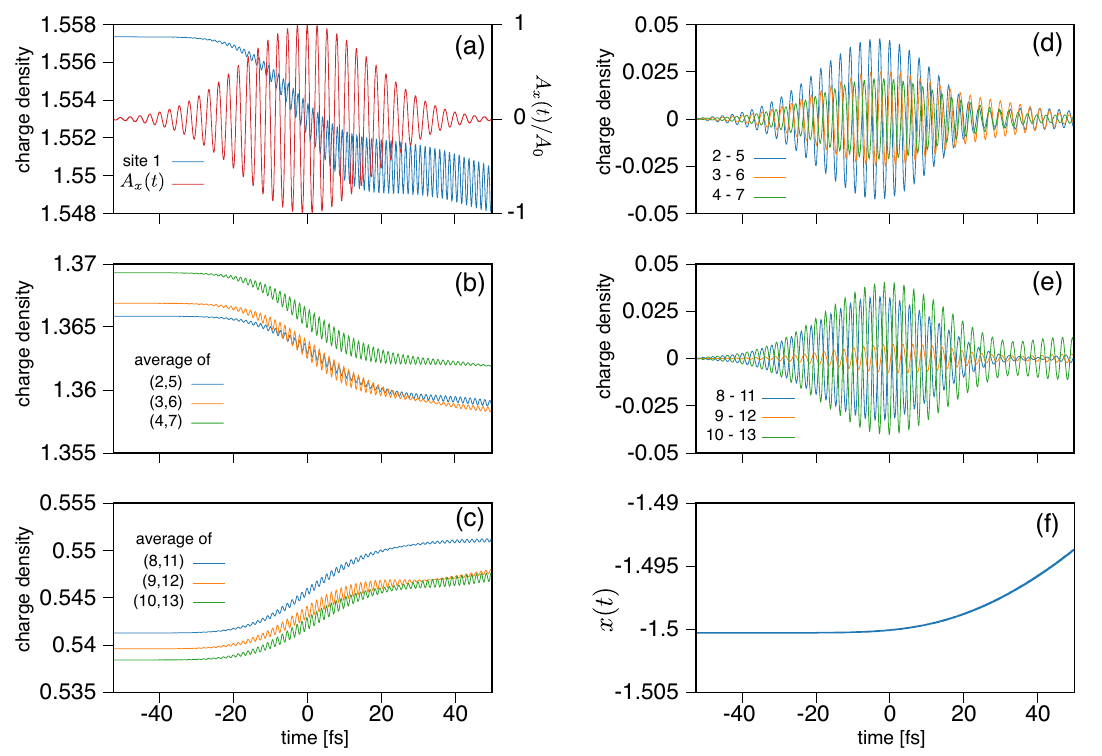
Figure 5. Dynamics results for E 0 = 0.92MV/cm on short time scale. ( a ) shows the charge density at A site (i.e., site 1) (see Figure 1b for the site index), and the input vector potential A x ( t ) (Equation (15)); ( b , c ) show the time profiles of the average charge density for the pairs of the “B” sites [ ( 2,5 ) , ( 3,6 ) , and ( 4,7 ) ], and the “C” sites [ ( 8,11 ) , ( 9,12 ) , and ( 10,13 ) ], respectively; ( d , e ) show those of charge-density difference in the pairs of the “B” sites [ ( 2,5 ) , ( 3,6 ) , and ( 4,7 ) ], and the “C” sites [ ( 8,11 ) , ( 9,12 ) , and ( 10,13 ) ], respectively; ( f ) shows the time evolution of the lattice distortion x ( t )